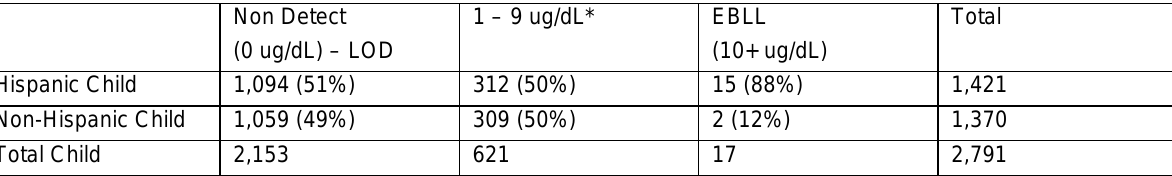
Clark County, NV Blood Lead Levels in Children by Ethnicity (August 2004 through August